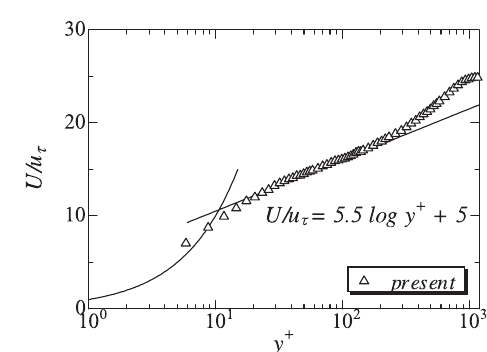
Fig. 3 Vertical profile of mean velocity